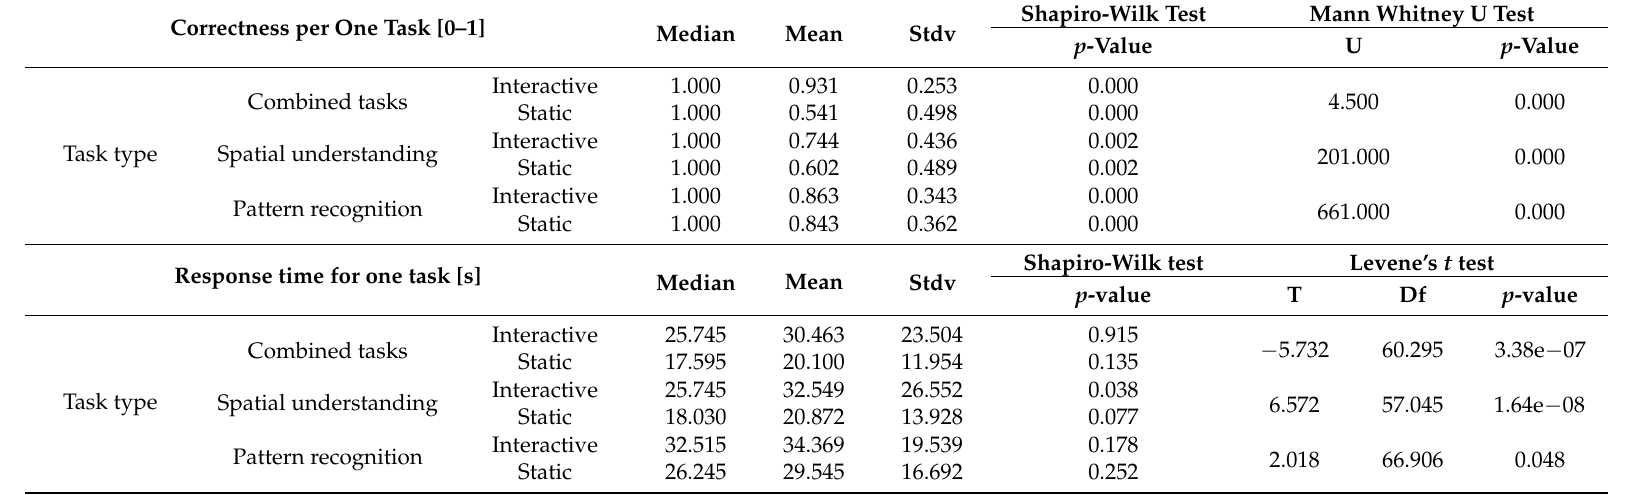
Table 6. Overall measures (correctness and response time) and analyses results for the task types